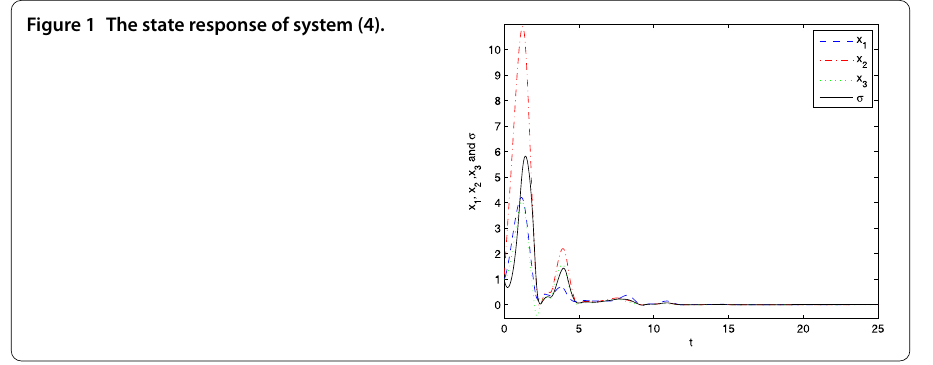
Figure 1 The state response of system